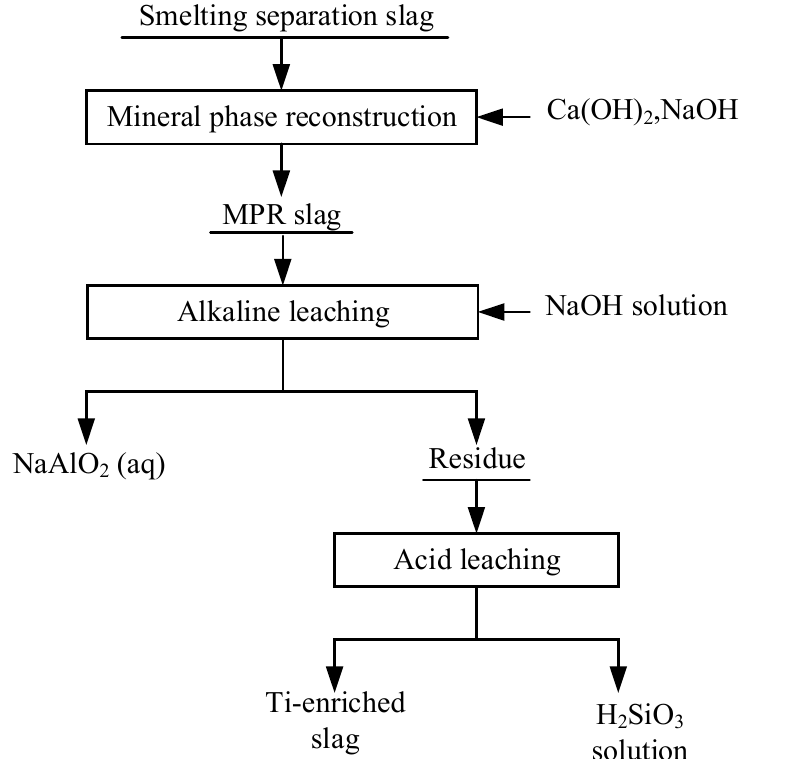
Figure 3. Experimental flowsheet of the proposed SSS treatment process.